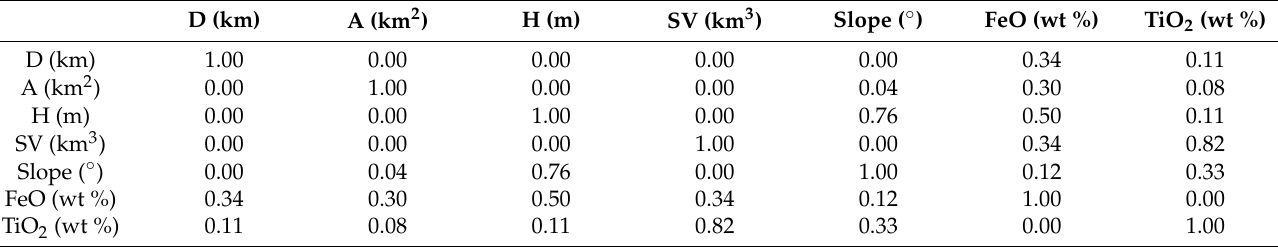
Table A3. The significance level of the feature correlation coefficients of all the 54